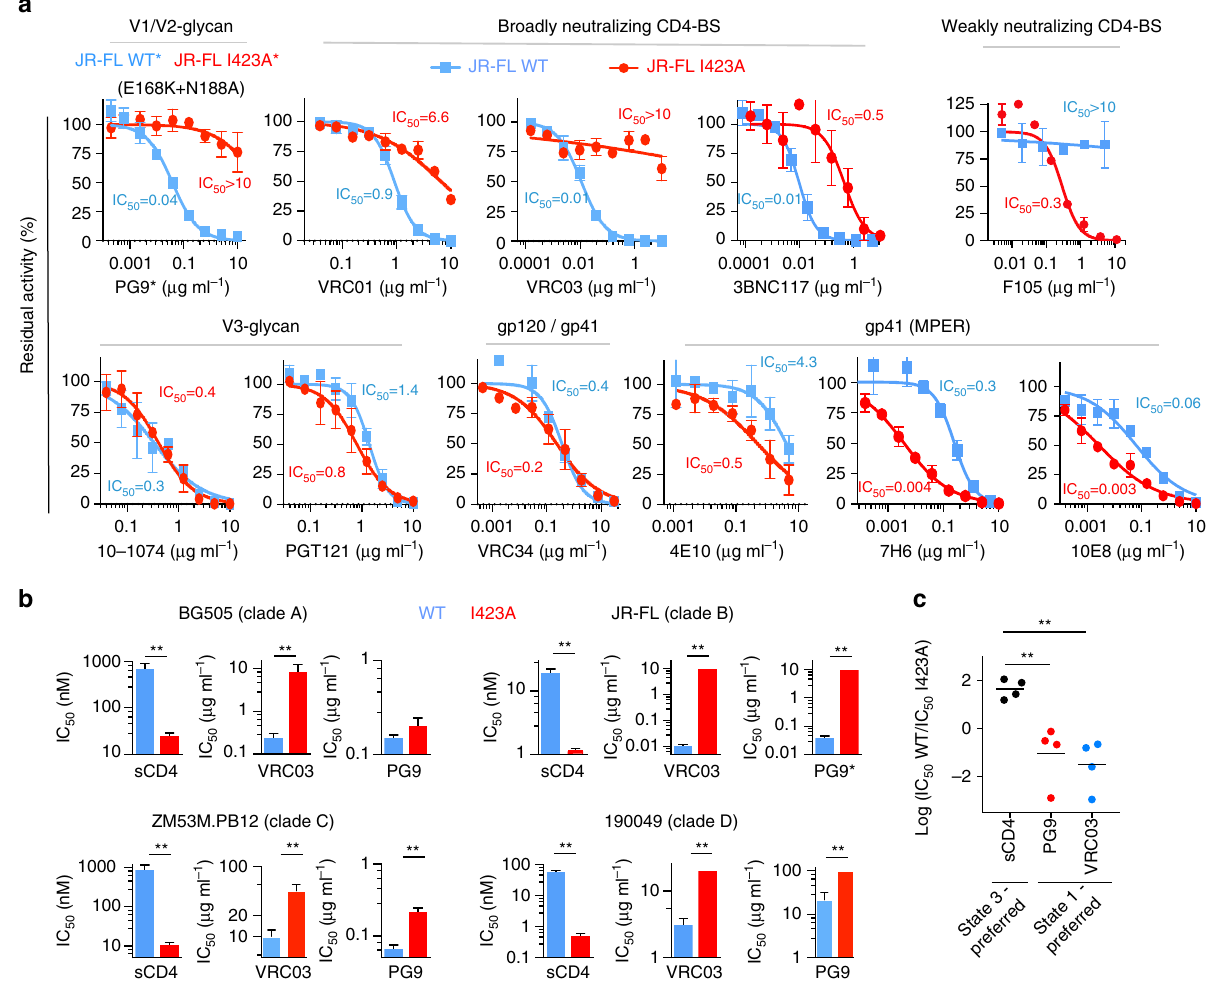
Fig. 4 The effects of the I423A change in different primary HIV-1 strains on Env conformational state and sensitivity to broadly neutralizing antibodies. a Neutralization of wild-type (WT) (blue) and I423A (red) HIV-1 JR-FL by different bNAbs. The calculated IC 50 s are shown. b Conformation-selective bNAbs and sCD4 were used to test the sensitivity of the WT (blue) and the I423A variant (red) of HIV-1 strains from clades A, B, C, and D. Reported IC 50 units are nM for sCD4 and μ g ml − 1 for the bNAbs. The asterisk (*) indicates that sensitivity of the PG9 antibody was tested against the HIV-1 JR-FL E168K + N188A Env (with and without the I423A change); these V2 changes restore the PG9 epitope in the HIV-1 JR-FL Env 32, 47 . c Comparison of the sensitivity of all isolates from b to ligands that prefer State 1 and State 3. Results shown are the average of those obtained in two or three independent experiments and error bars represent s.e.m. The double asterisk (**) indicates one-tail P values < – 33 (Fig. 4a, b)) 18, 19, 24, 31 . These results indicate that, relative to